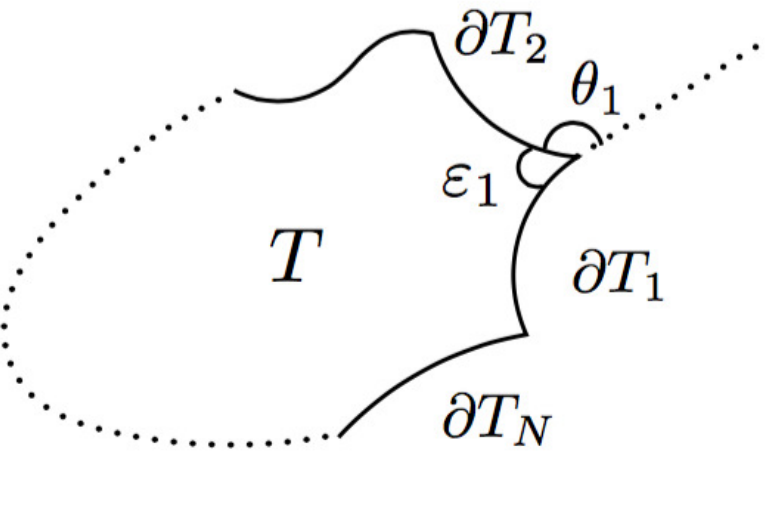
Figure 1. Gauss–Bonnet theorem: We consider a closed curve in a surface.